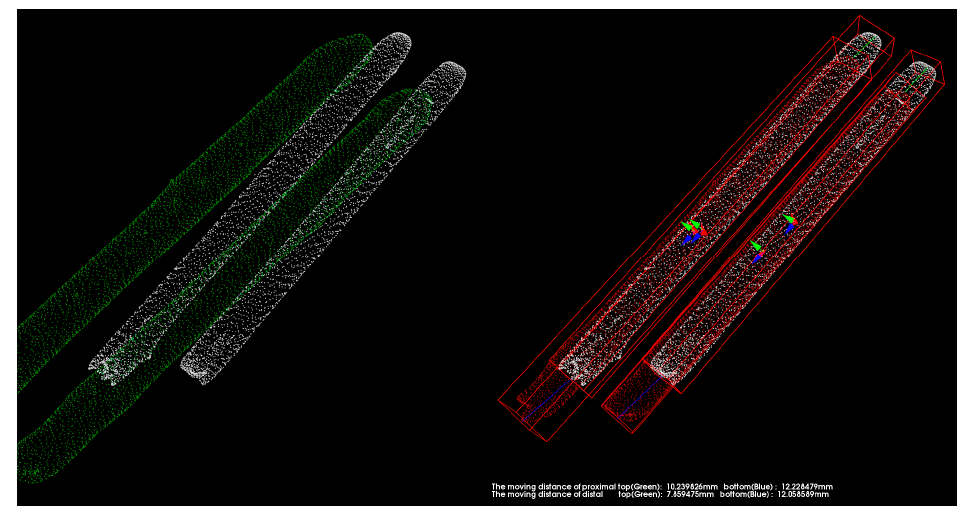
Figure 13. Visualization of pins’ movement and calculation of moving distance and rotation angle. Table 3. The length of pins and information of patients in each case. Case